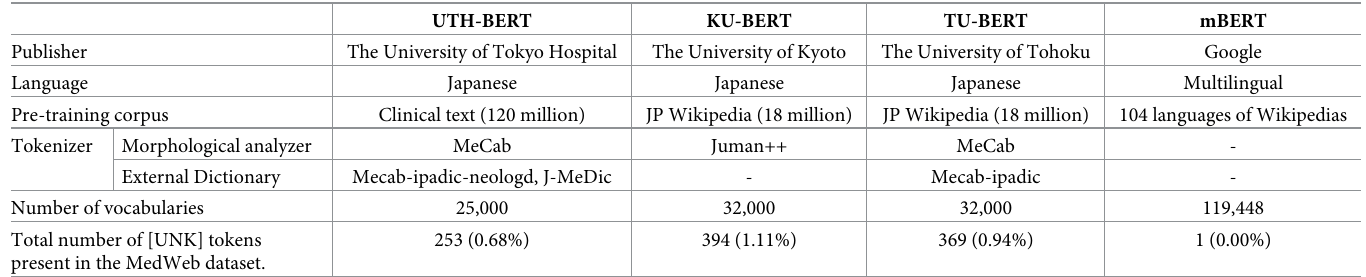
Table 2. The specifications of each BERT.